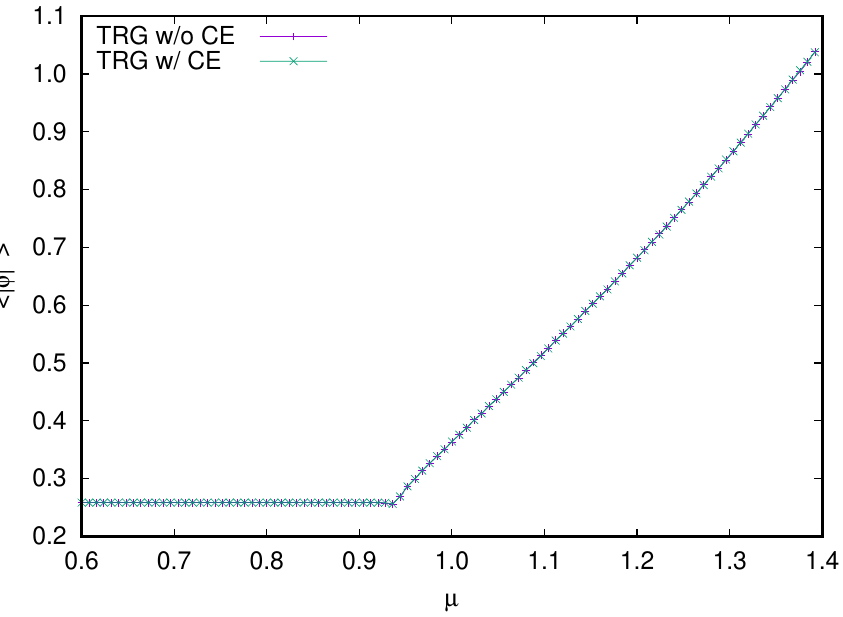
Figure 9 . Comparison of hj (cid:30) j 2 i obtained by two di(cid:11)erent TN formulations with D = 64 on V = 1024 2 . We use K = 64 for the (cid:12)rst representation without the character expansion and N CE = 128 and K = 256 for the second one with the character expansion. See the appendix for the details.